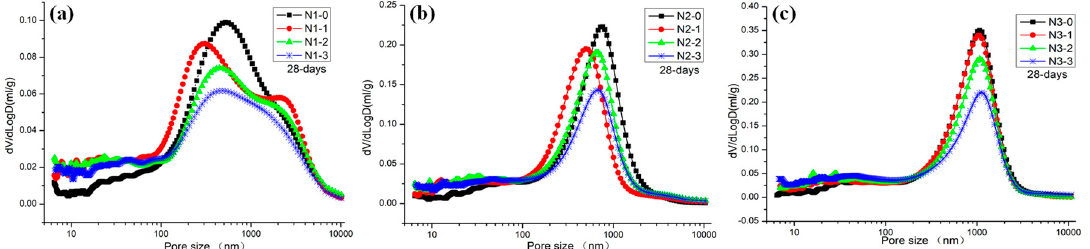
Figure 10. Effect of LS pretreatment on the pore size distribution of NHL mortar: ( a ) Group N1, ( b ) group N2, and ( c ) group N3.